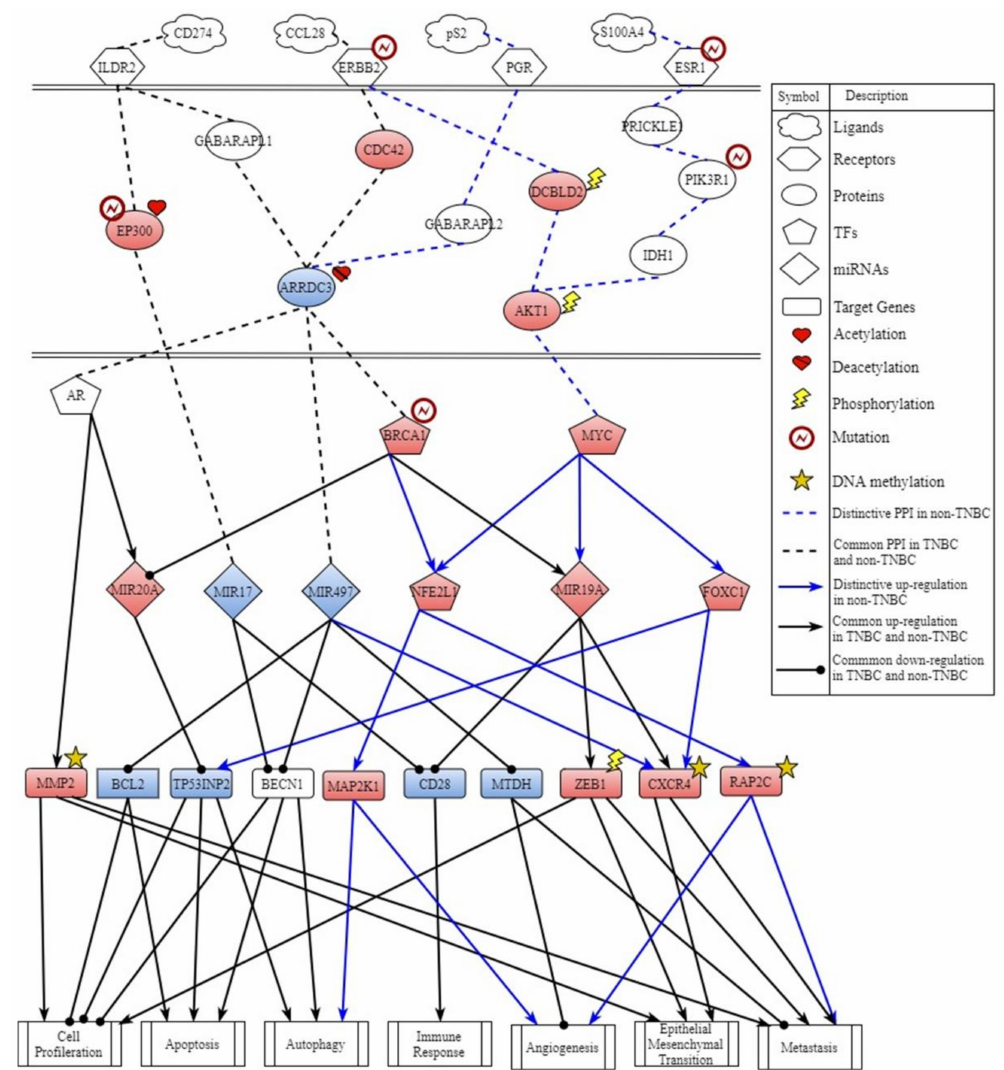
Figure 4. Core signaling pathways of non-triple negative breast cancer (non-TNBC). The black arrow head of the solid line means activation of cellular function; the black circle head of the solid line means inhibition of cellular function; the red node indicates high expression of protein, receptor, TF, miRNA, and target gene; the blue node indicates low expression of protein, receptor, TF, miRNA, and target gene; the blue line indicates distinctive core signaling pathway of non-TNBC; and the black line indicates common core signaling pathway of TNBC and